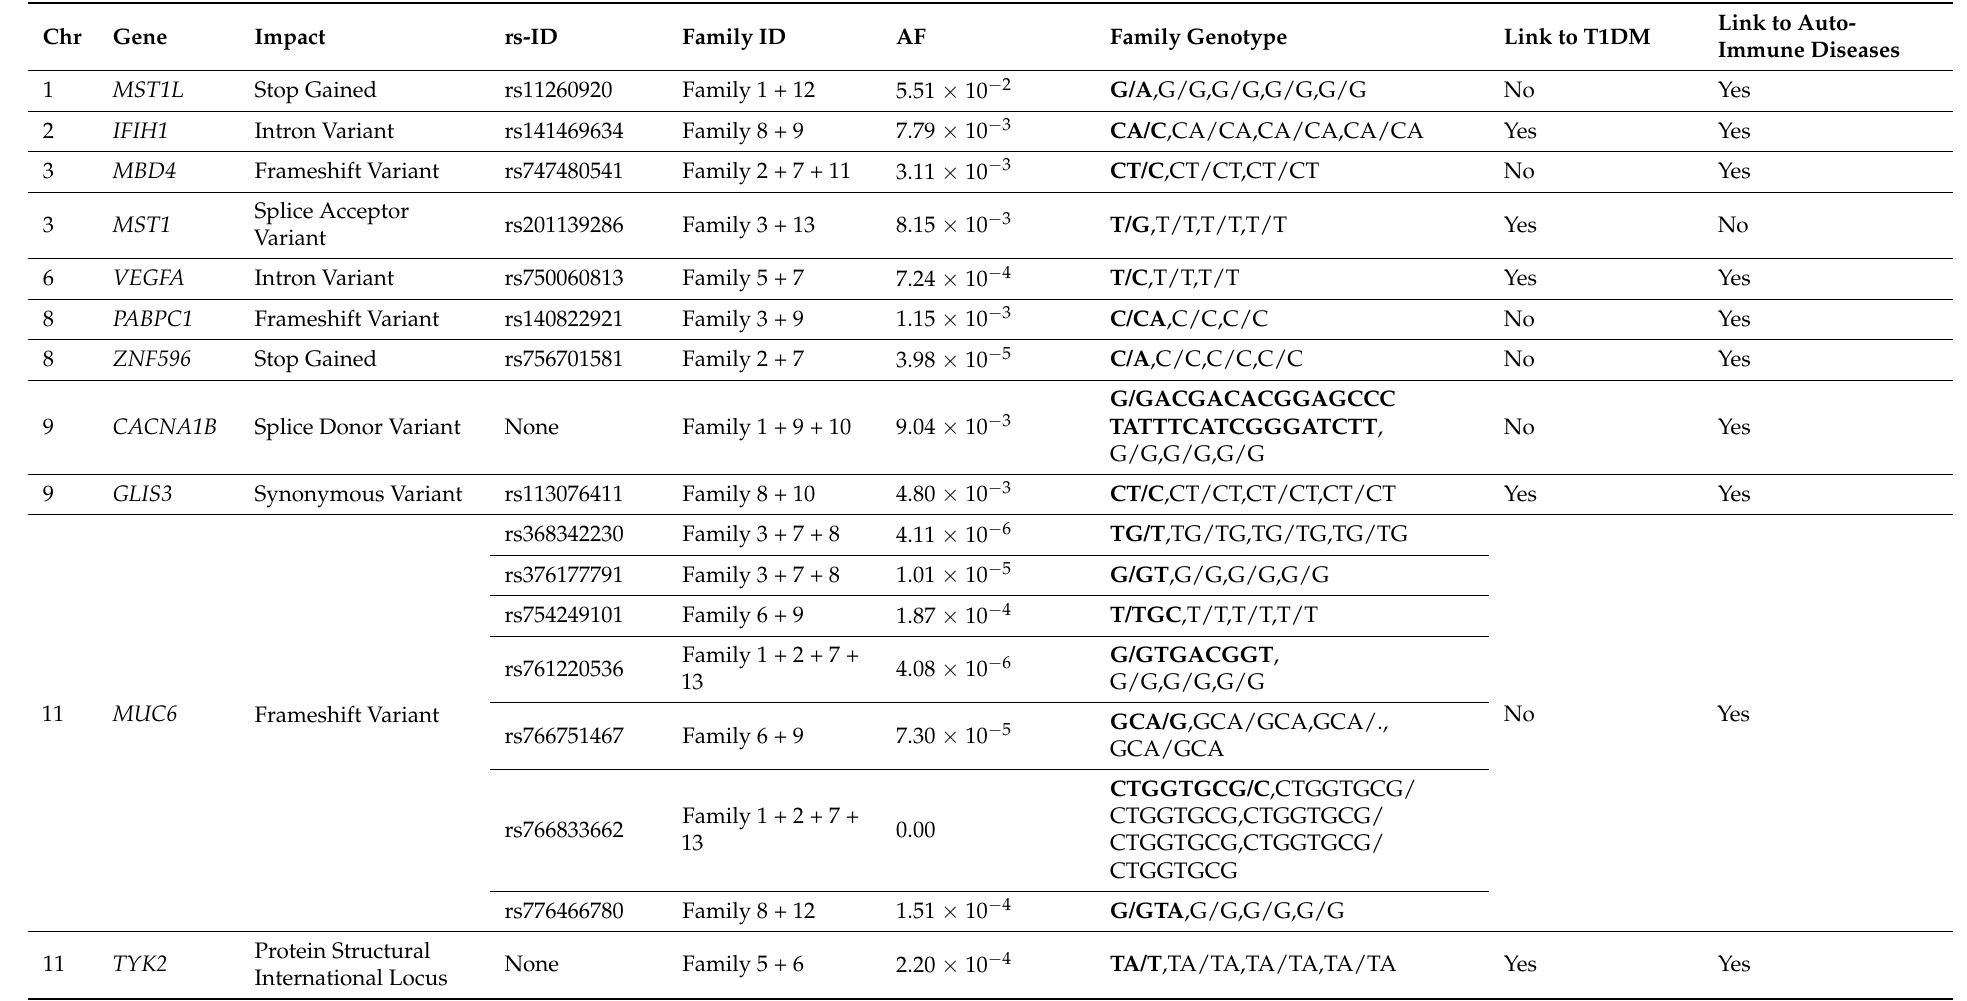
Table 2. De novo genes with rare variants identified from 13 Emirati case–parent trios with